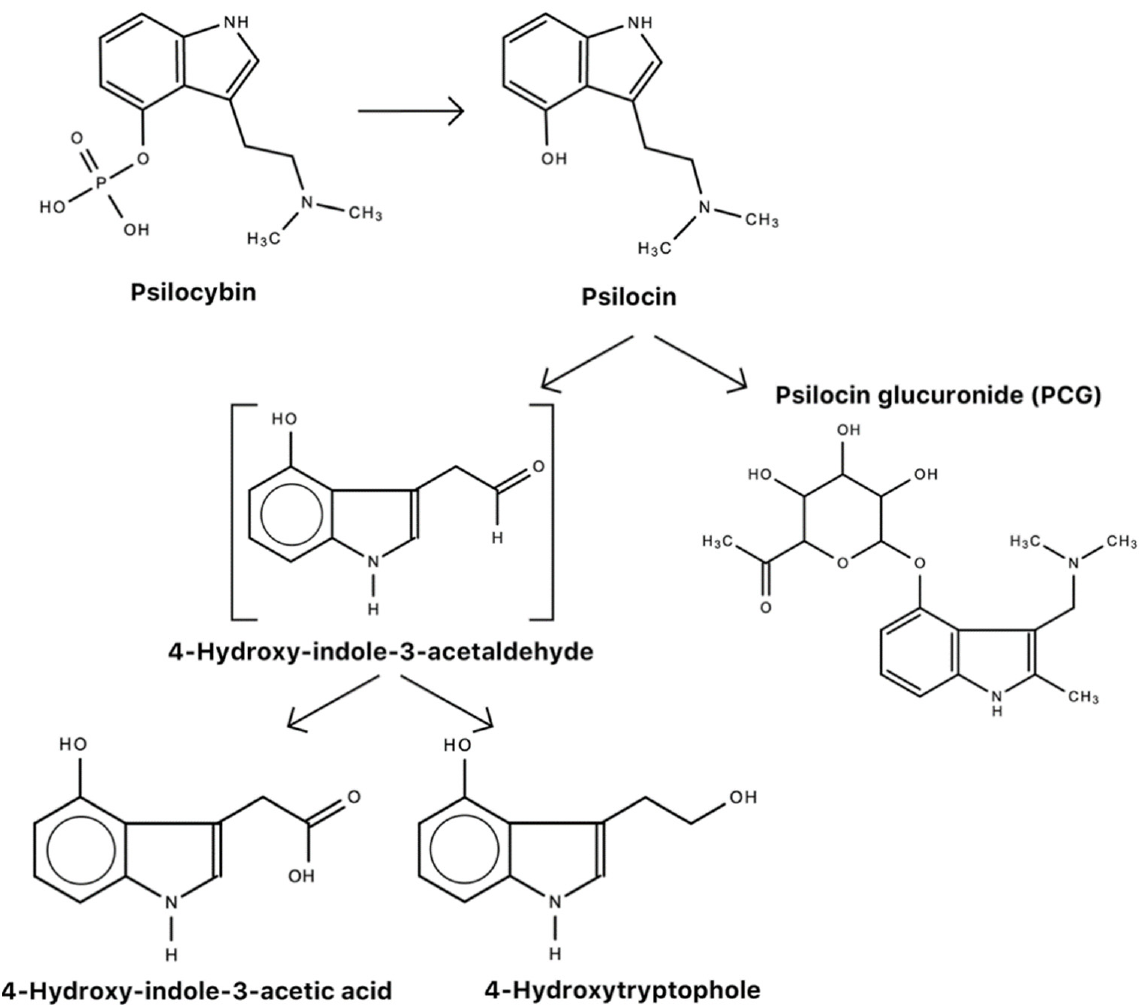
Figure 7. Metabolism of psilocybin [5,253,254].